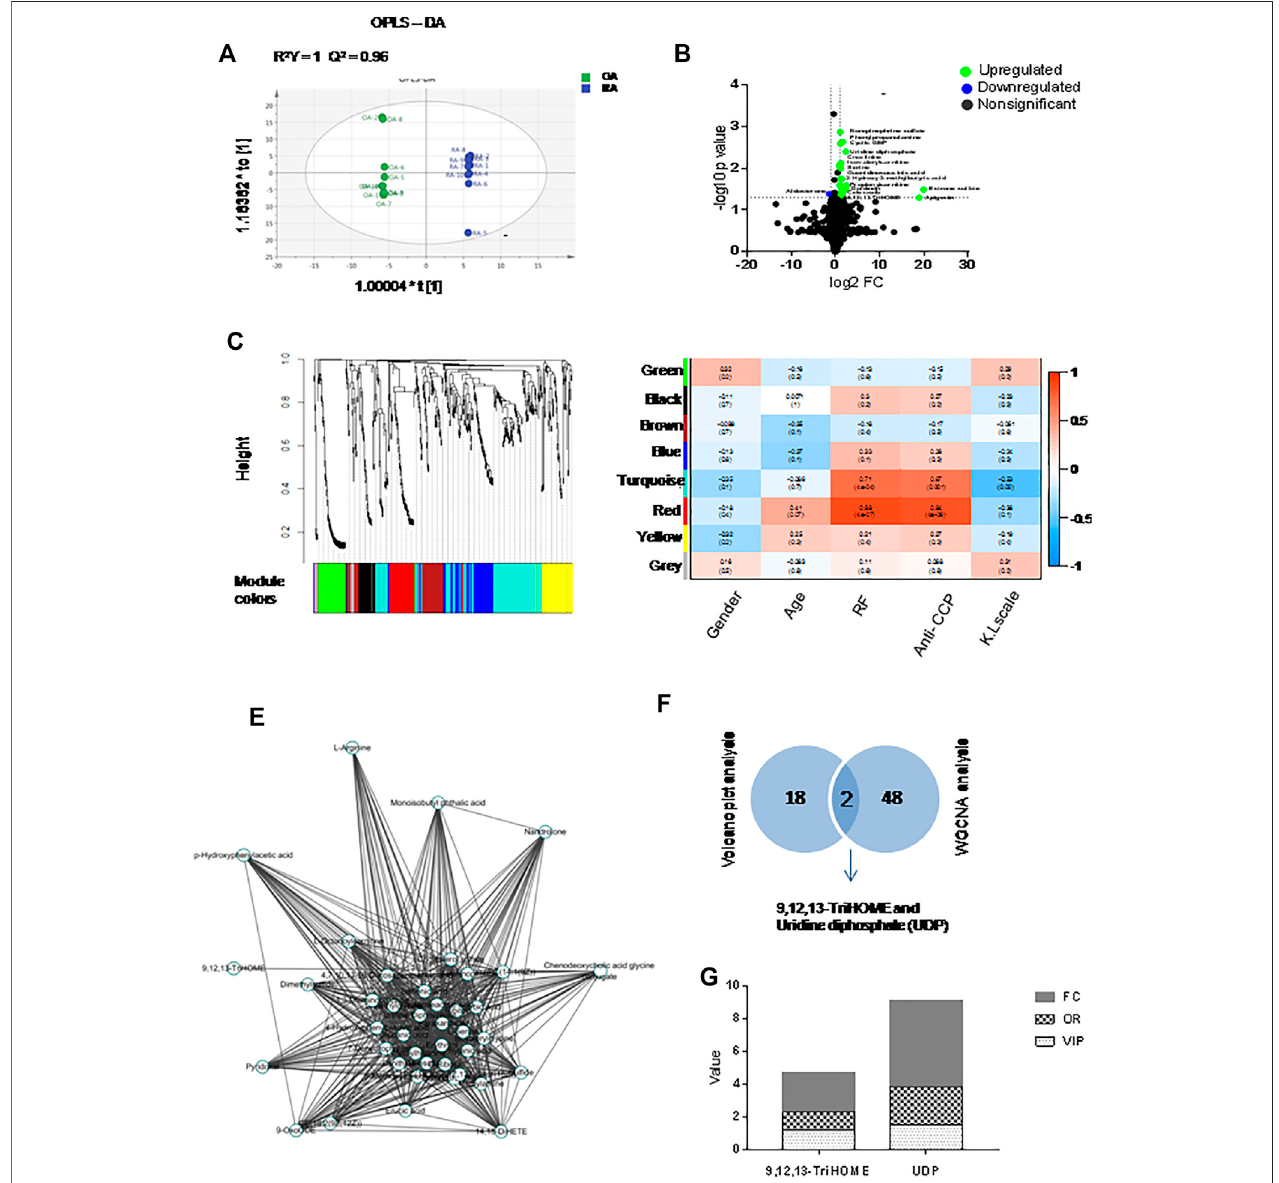
FIGURE1| Multivariatestatisticalanalysisformetabolomicsdatawithsynovial fl uids. (A) OPLS-DAofsynovial fl uids( n (cid:1) 10forRAandOA). (B) Volcanoplotsindicating the statistical signi fi cance of metabolite changes between RA and OA samples ( p < 0.05; FC > 2). (C) Clustering dendrograms of the metabolite sets. (D) Correlation of metabolitecoexpressionnetworkmoduleswiththeclinicalfeaturesofRApatients. (E) Metaboliteexpressionnetworkderivedfromtheredmodule. (F) Venndiagramsofkey metabolites in the volcano plot analysis and WGCNA sets. (G) Histogram of key metabolites (9,12,13-TriHOME and UDP) based on FC, OR, and VIP.